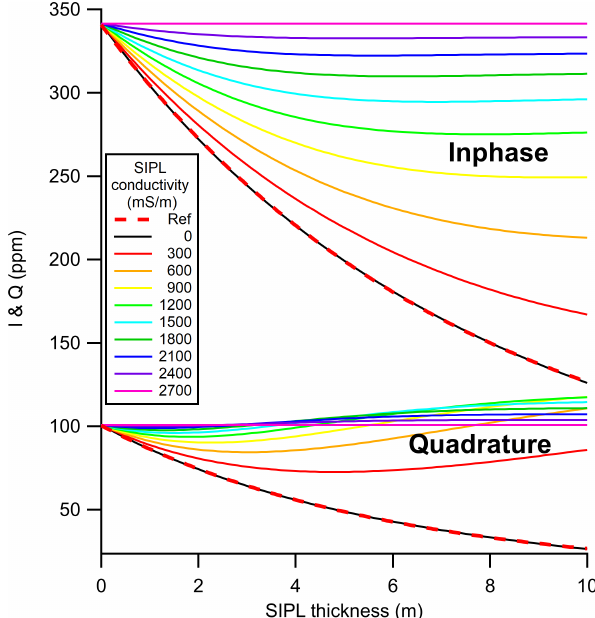
Figure 3. In-phase I and quadrature Q responses to a 0 to 10m thick SIPL under 2m thick consolidated ice for SIPL conductivi- ties of 0 to 2700mSm − 1 computed with a three-layer EM forward model (see Fig. 2). Ref shows negative exponential curves for con- solidated ice with zero conductivity used for computation of I and Q apparent thicknesses using Eq.